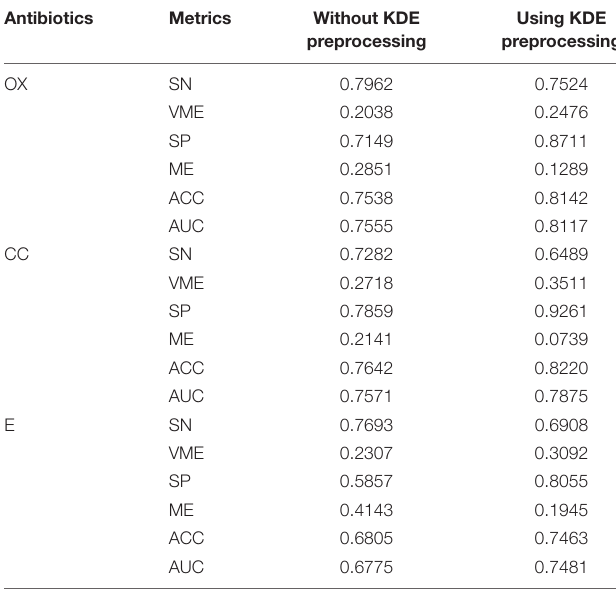
TABLE 2 | Results of with or without kernel density estimation (KDE) preprocessing on independent testing set. Antibiotics